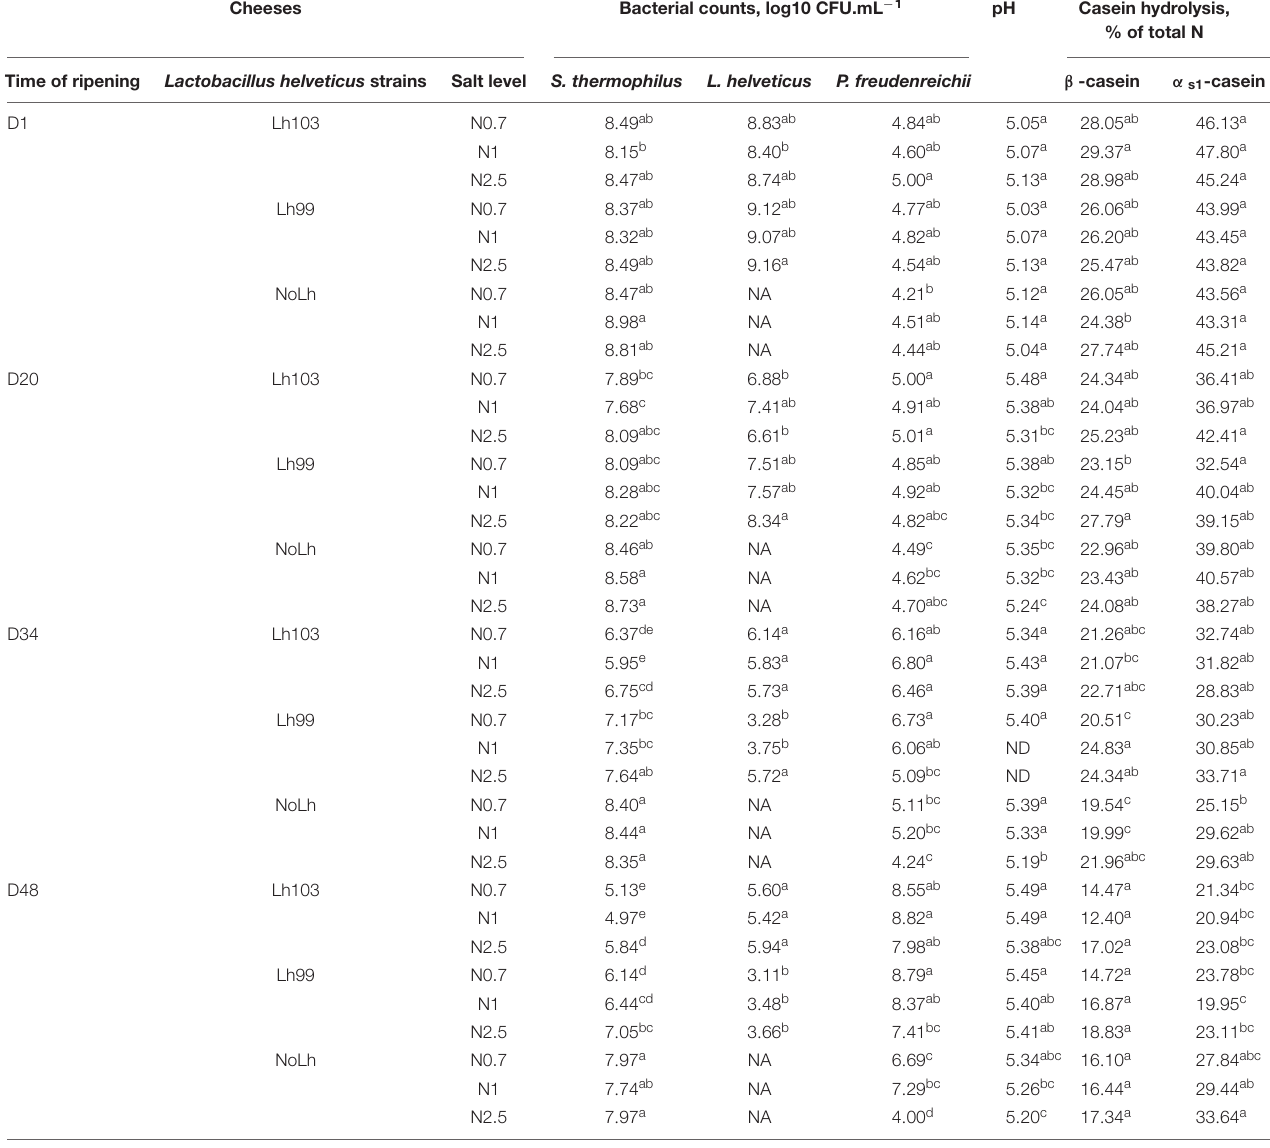
TABLE 3 | Bacterial and biochemical composition of Swiss cheeses manufactured with different NaCl contents and Lactobacillus helveticus strains.